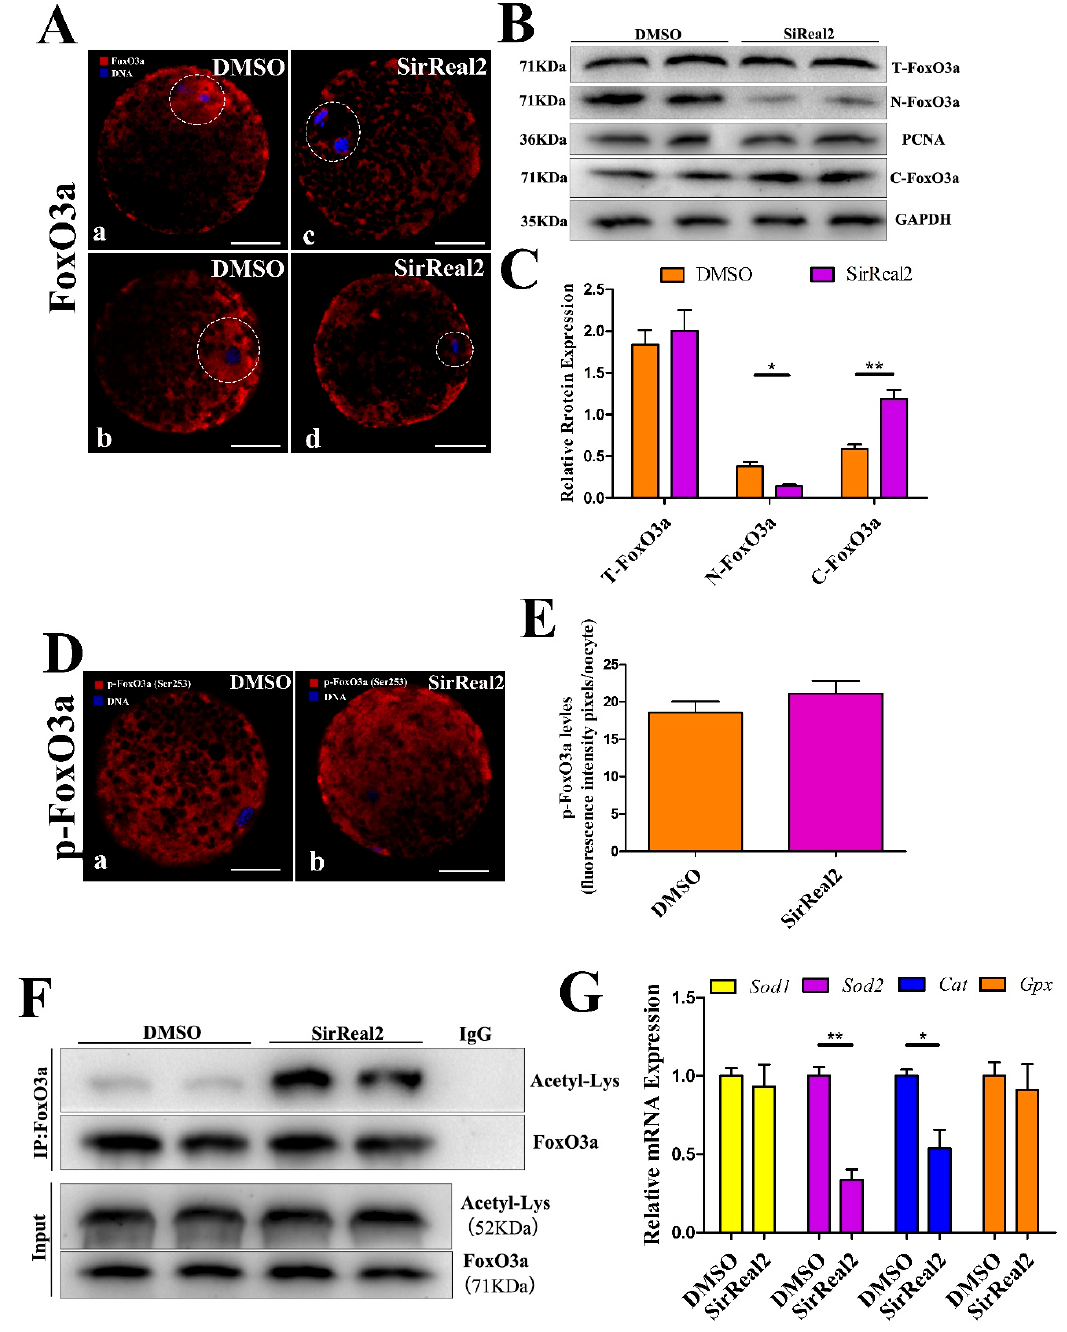
Figure 7. SIRT2 mediated the FoxO3a–SOD2/Cat axis. ( A ) SIRT2 inhibition blocked the nuclear translocation of FoxO3a. Oocytes were immunolabeled with FoxO3a antibody (red) and counterstained with DAPI to visualize DNA (blue) in the control (a,b) and 5 µ M SirReal2-exposed groups (c,d). At least 100 control oocytes and 100 SirReal2-exposed oocytes were analyzed. Scale bar: 20 µ m. ( B ) The protein expression of FoxO3 in the nucleus, cytoplasm, and overall. GAPDH and proliferating cell nuclear antigen (PCNA) were used as internal controls for the cytoplasmic and nuclear fractions, respectively. ( C ) Quantitative analysis of protein expression of the T-FoxO3a, N-FoxO3a, and C-FoxO3a. Band intensities normalized to GAPDH or PCNA are shown. The ratios of T-FoxO3a to GAPDH, N-FoxO3a to PCNA, and of C-FoxO3a to GAPDH expression were normalized, and the values are indicated. ( D ) Confocal imaging analysis for p-FoxO3a levels in the control (a) and 5 µ M SirReal2-exposed groups